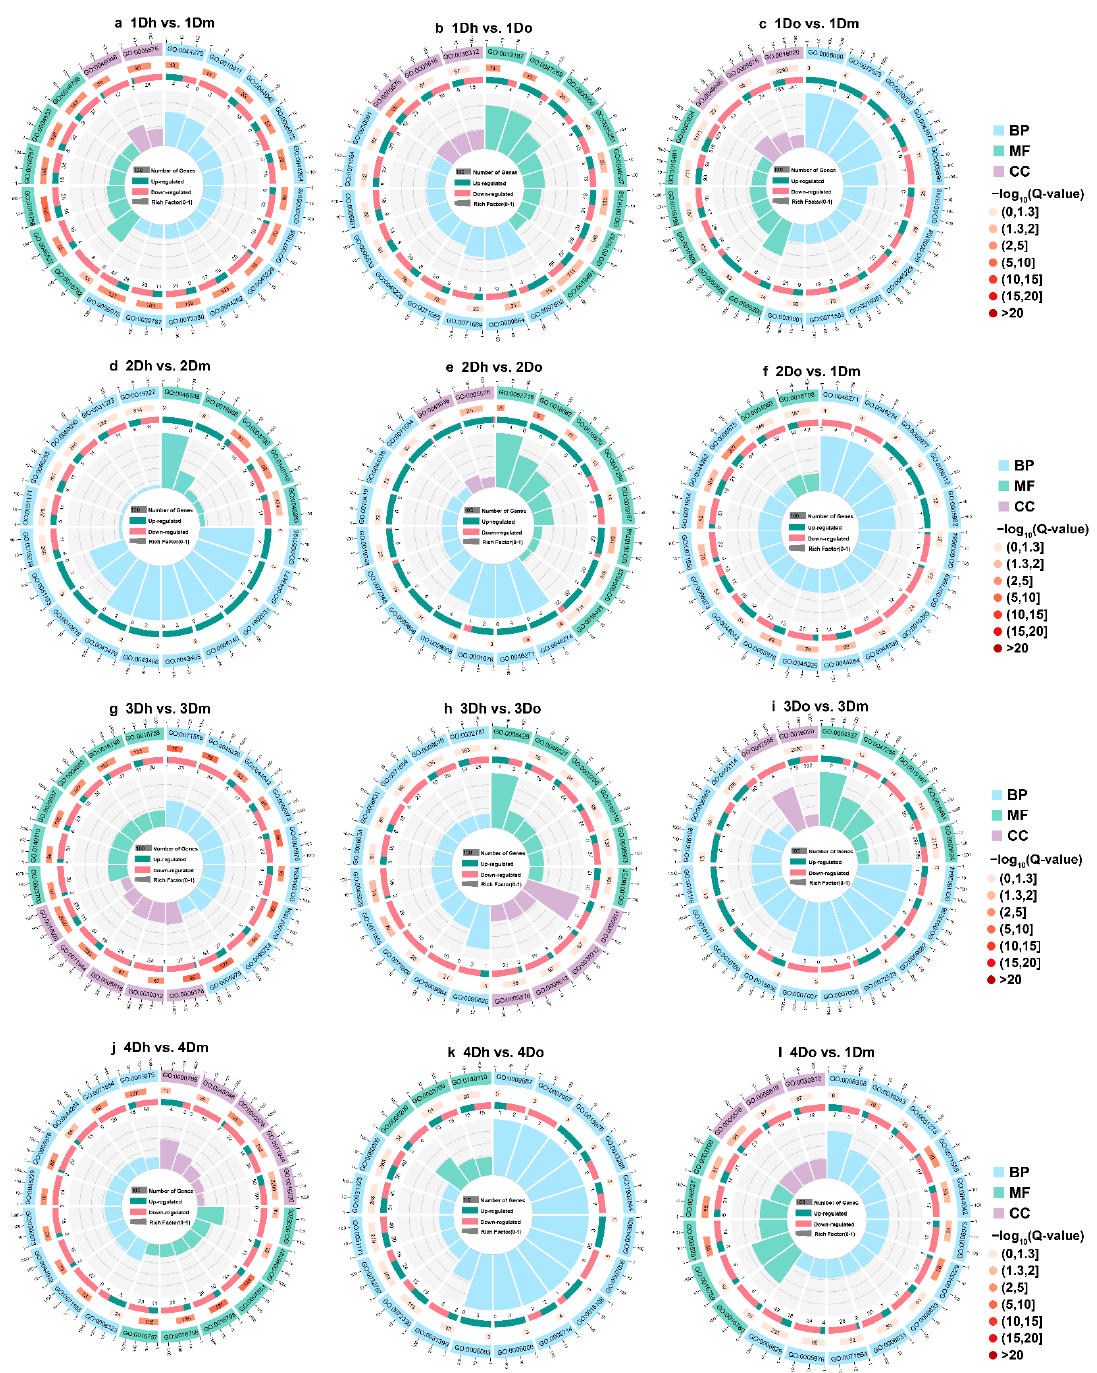
Figure 4. GO enrichment analysis of DEGs. The secondary categories of GO include Biological Process (BP), Molecular Function (MF), and Cellular Component (CC). These figures consist of four circles from outside to inside. The first circle is the enriched classification, and the outer circle is the scale of the number of genes. The combination of letters and numbers is the ID of the GO term. The three colors represent BP, MF, and CC, respectively. The second circle is the number of background genes and the q-value of the GO term. The p -value after FDR correction is called q-value. The more DEGs are enriched, the longer the box is. The smaller the q-value, the darker the color of the box, in-